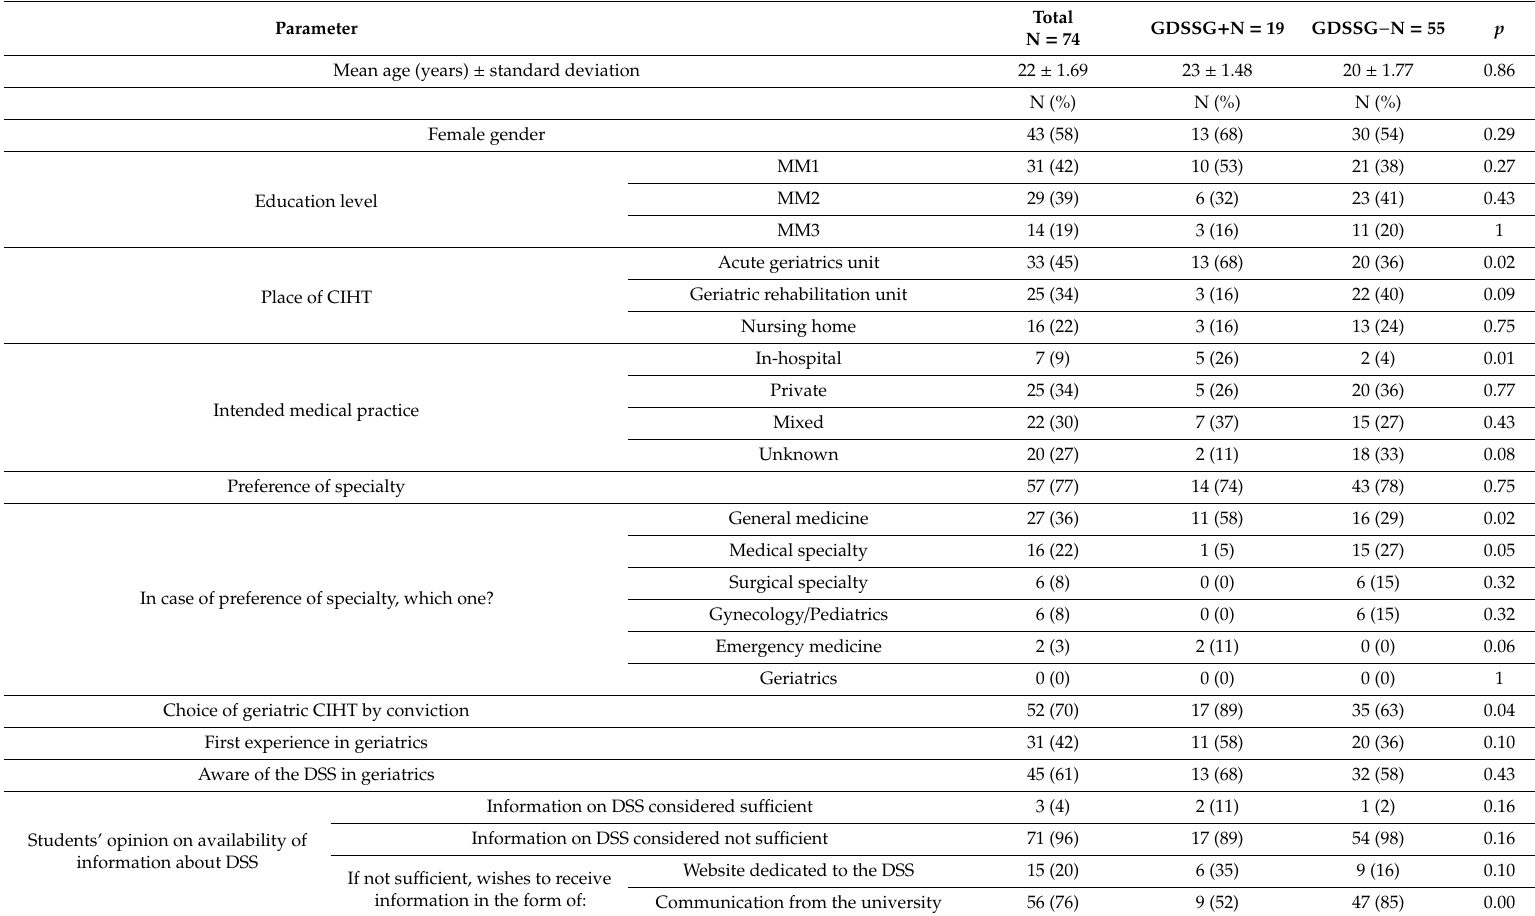
Table 1. Student characteristics at the beginning of in-hospital